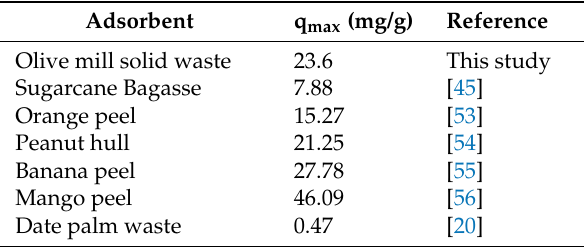
Table 8. Comparison of rate constants for Cu(II) adsorption onto olive